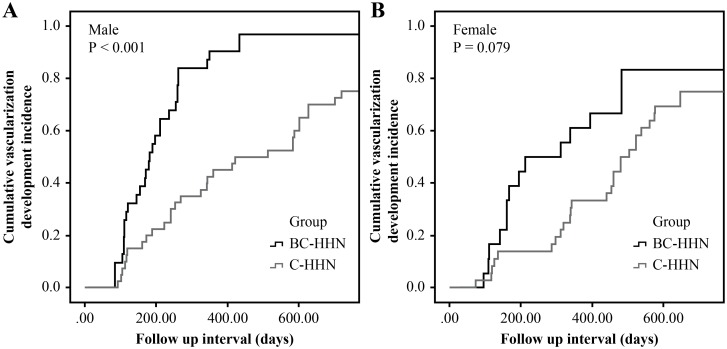
Comparison of cumulative incidence of vascularization development between groups stratified by sex.(A) male; (B) female.